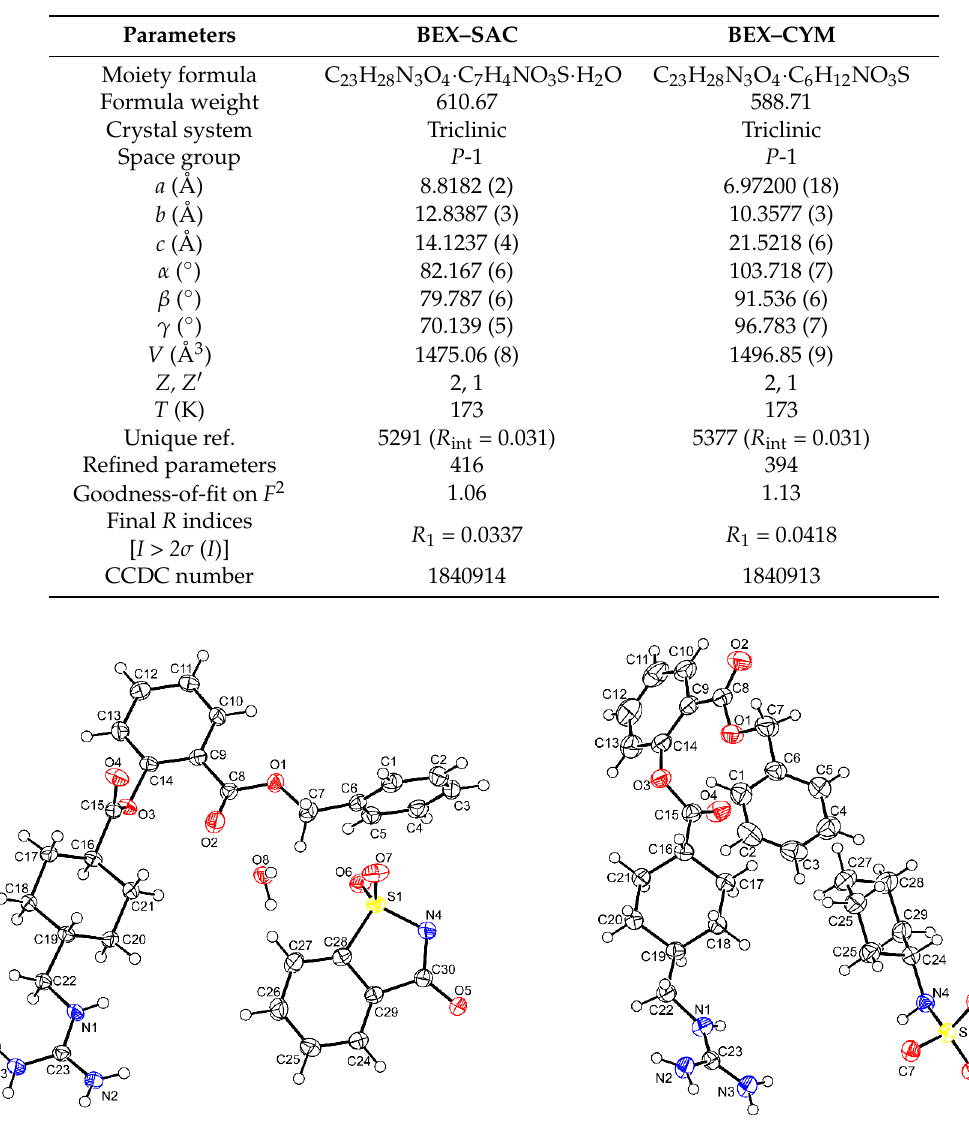
Table 1. Crystallographic details of benexate-saccharinate (BEX–SAC) and benexate-cyclamate (BEX–CYM).